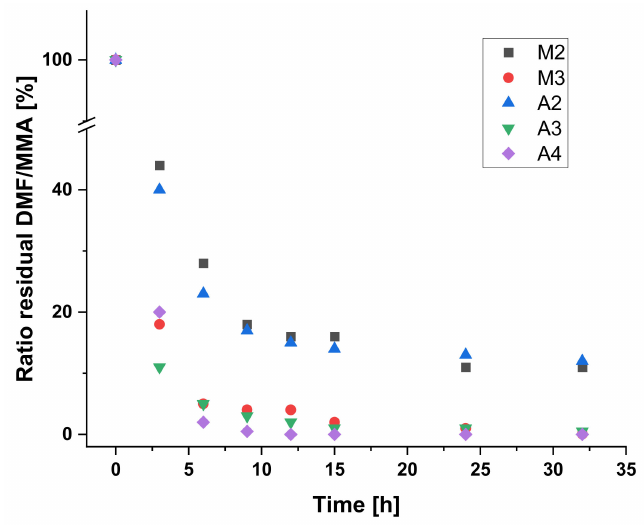
Figure 3. Representation of the decrease in the residual DMF ( M3 , A3 , A4 ) or MMA ( M2 , A2 ) during dialysis time. Table 4. Analysis of the e ffi ciency of the manual ( M2 , M3 ) and the automated ( A2 to A4 ) dialysis measured using gas chromatography and NMR spectroscopy. In the case of the reaction solution, the residual solvent (dimethylformamide (DMF)) was measured ( M3 , A3 , A4 ) (NMR signal at 8.02 ppm compared to signal of anisole at 6.75 to 6.90 ppm), in the case of the other ( M2 , A2 ) the additional methyl methacrylate (NMR signal at 5.5 ppm compared to signal of anisole at 6.75 to 6.90 ppm) was analyzed. The values are given in percentages relative to the sample at the beginning of the